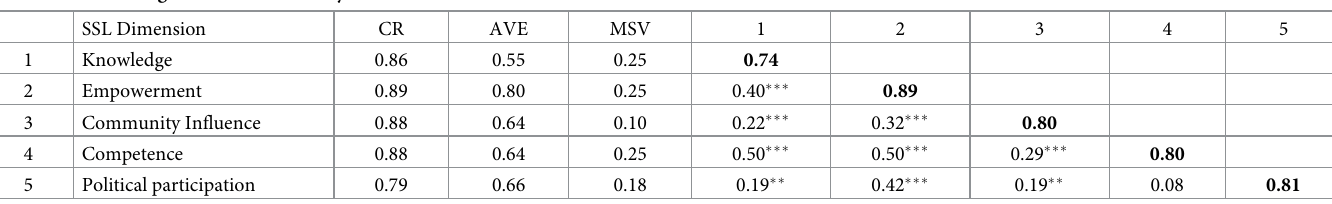
Table 4. Establishing discriminant validity of SSL